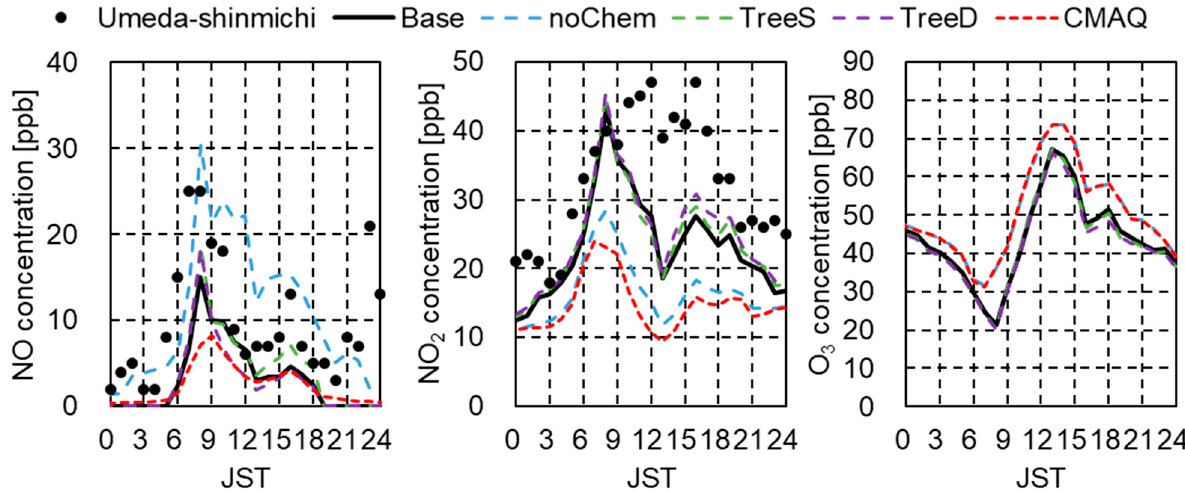
Figure 7. Time series of pollutants concentration inside the canyon. Umeda-shinmichi is the observation station locating in calculation domain (see Figure 1), at which O 3 was not observed. CMAQ is the calculation results of CMAQ, which was used as the boundary condition of the CFD calculations.